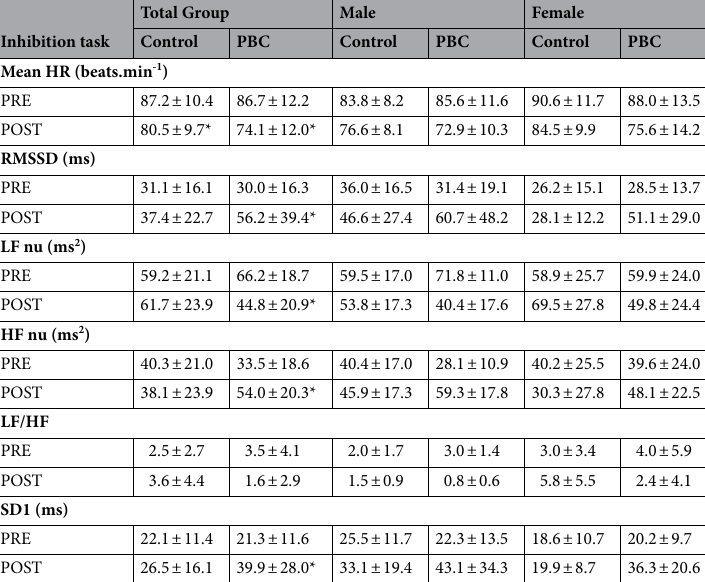
Using a randomized controlled counterbalanced cross-over design, we tested the effect of PBC on cognitive per- formance, cardiac autonomic control, and cerebral oxygenation in young healthy males and females. We provide novel data showing that (1) a 3-min PBC exposure improved cognitive inhibition performance assessed in a Stroop test in male participants only, and (2) this was accompanied by a decrease in cerebral oxygenation during exposure (in both males and females) followed by a greater cerebral O 2 (ΔHHb) extraction in males only, and